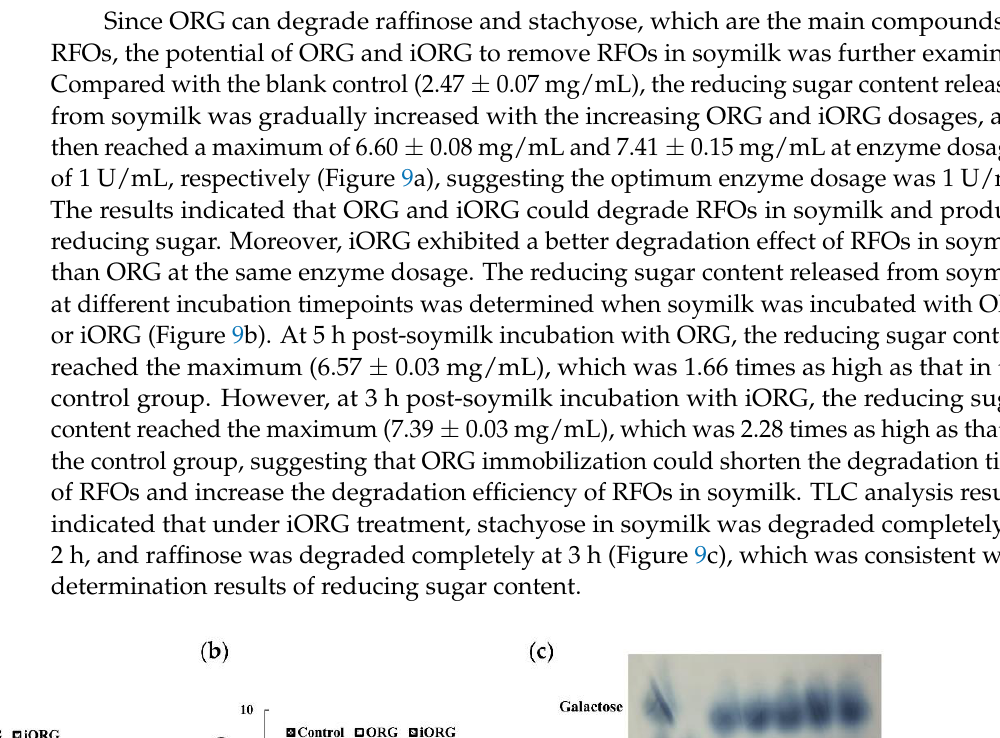
Figure 8. Storage stability of ORG and iORG at 4 °C ( a ) and room temperature ( b ); reusability of iORG ( c ).